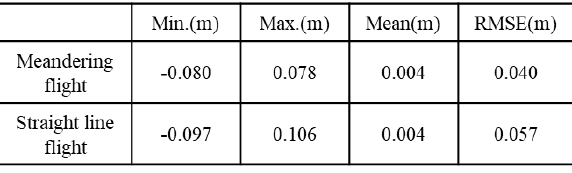
Table 4. Elevation verification accuracy of checking points in